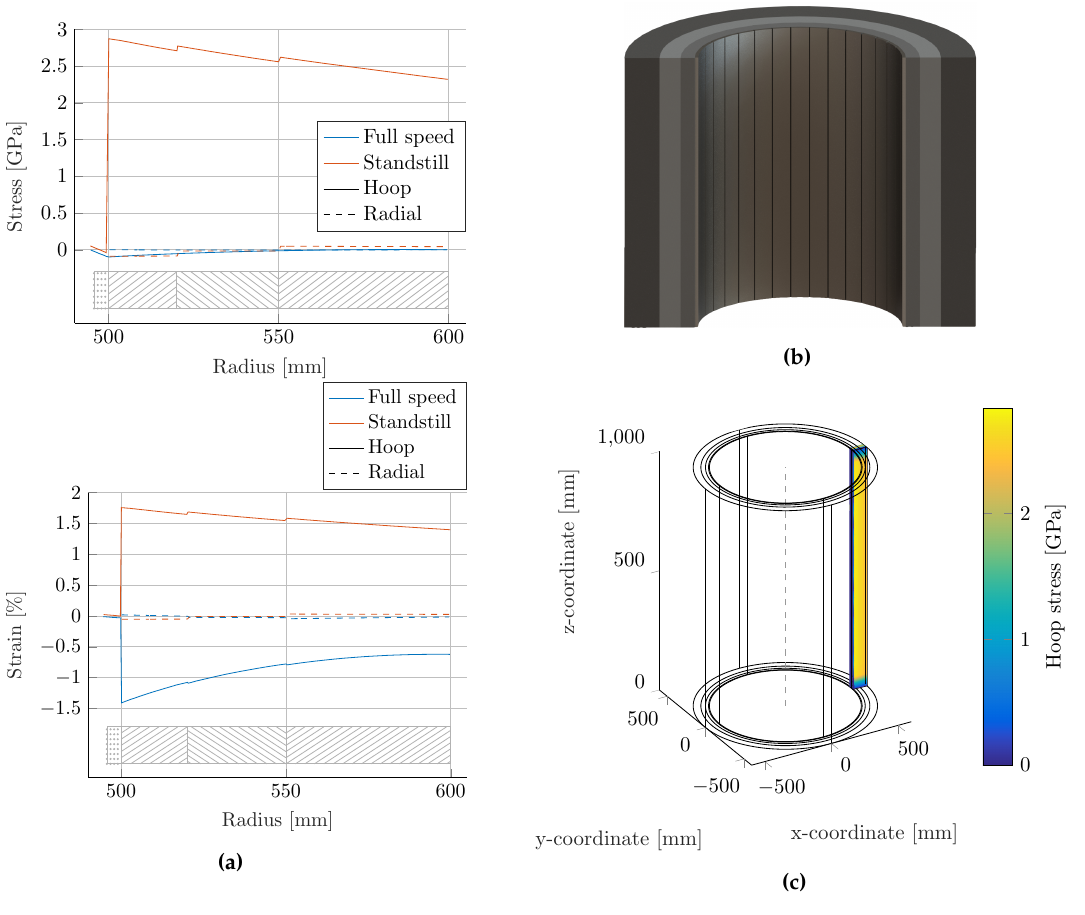
Figure 1. ( a ) Stress and strain of proposed design, from the FEA solution. The radial dimensions of the flywheel are illustrated at the bottom. The hatch pattern corresponds to composite material. The dotted pattern is steel. The materials are close to their respective stress and strain-limits; ( b ) concept drawing of rotor (not to scale). Note the lines in the innermost layer, representing slits in the steel; and ( c ) FEA solution of the hoop stress distribution inside the hollow cylinder. The simulated 5 ◦ segment is